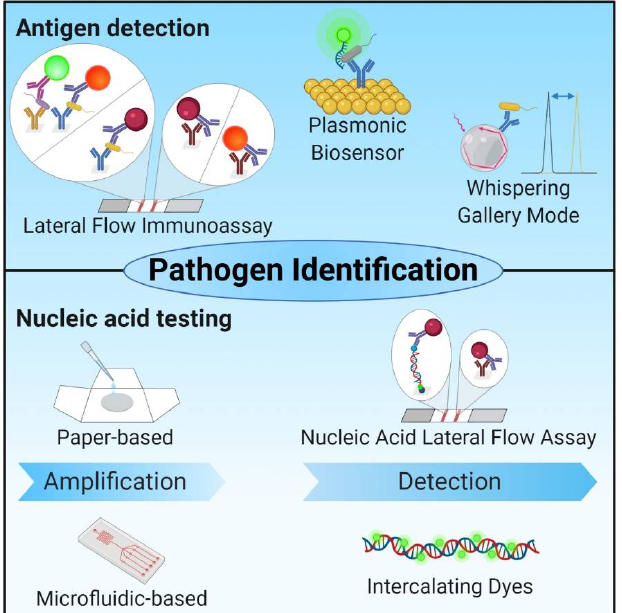
Figure 3. Illustration of different technologies for pathogen identification, suitable for point-of-care (POC) application. General approaches can be divided into antigen detection ( top ) and nucleic acid testing ( bottom ). Lateral Flow Immunoassays, for example, are readily applicable for detection of pathogen specific antigens, multiplexing-approaches for identification of several different species can be realized by incorporating different fluorescence labels (e.g., quantum dots). Furthermore, Plasmonic Biosensors show a great potential for POC applications, as sensitivity can be drastically increased and sample treatment can be avoided [105]. Another emerging technology for POC appli- cation is the Whispering Gallery Mode sensor technology, attracting much attention over the past decade. Here, the binding of molecules to the resonators surface can be detected as a change of the